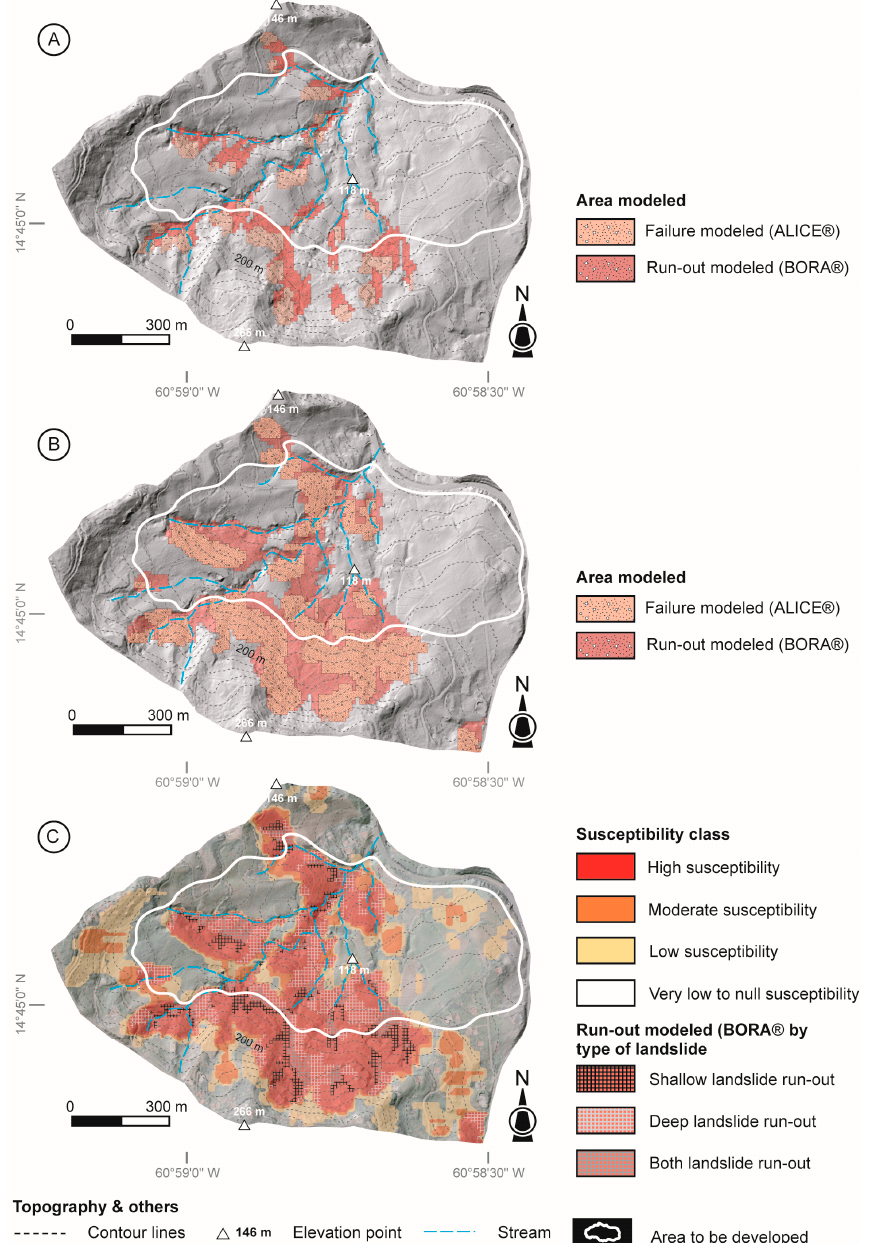
Figure 12. ( A ) Modeled translational landslide map representing shallow and translational landslides with failure and run-out; ( B ) modeled rotational landslide map representing shallow and deep landslides with failure and run-out; ( C ) unified modeled map representing modeled failure and modeled run-out (coordinates are expressed in Lat/Long; projection WGS84 UTM 20N - EPSG 32620).